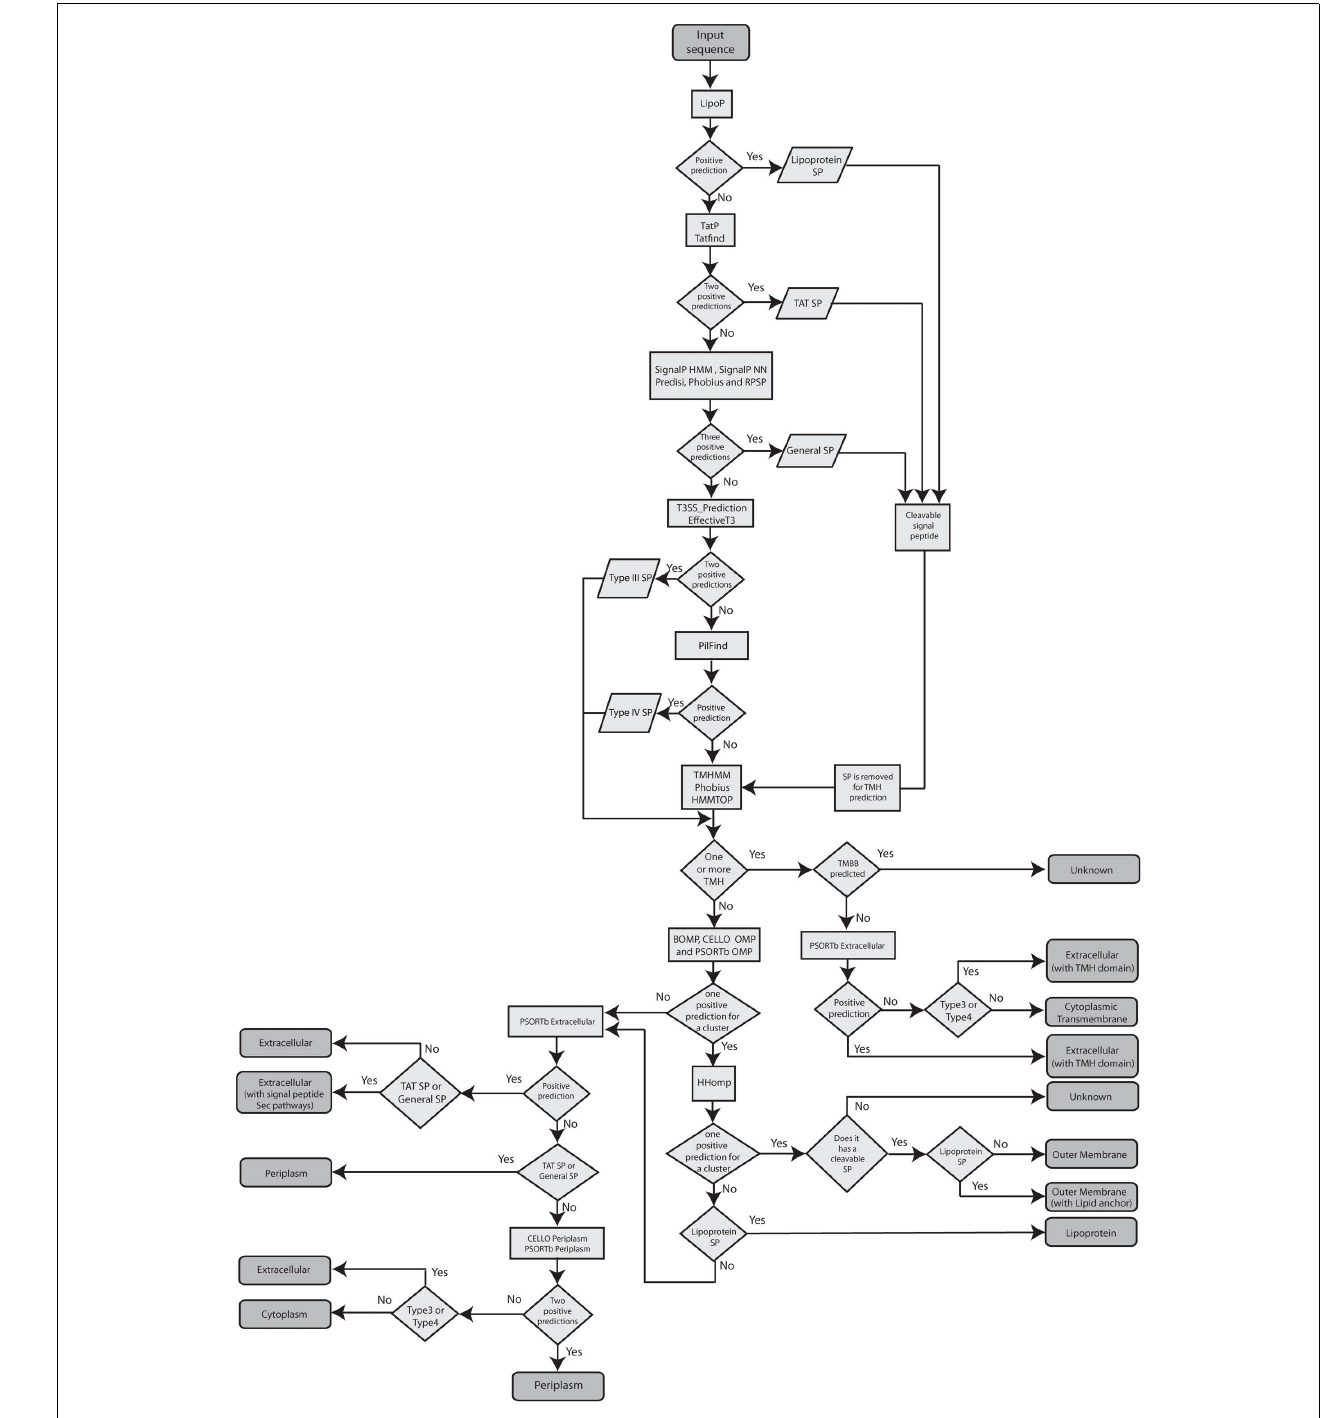
FIGURE 1 | Flowchart for SCL prediction at the level of single